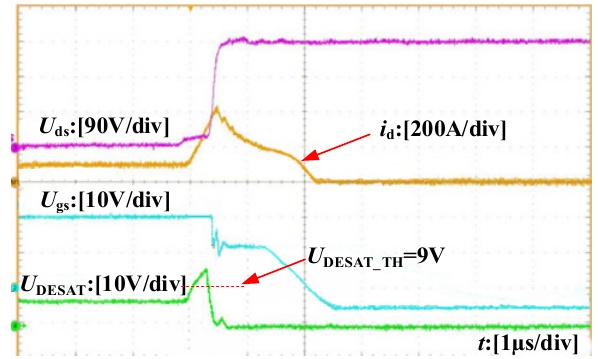
Figure 11. Experiment waveform of U ds , i d , U gs , U DESAT under FUL.